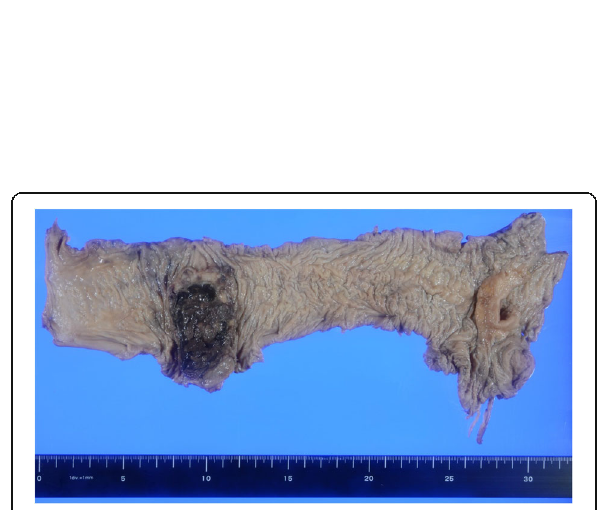
Fig. 2 Macroscopic findings of the resected specimen. The tumor size was 75 × 46